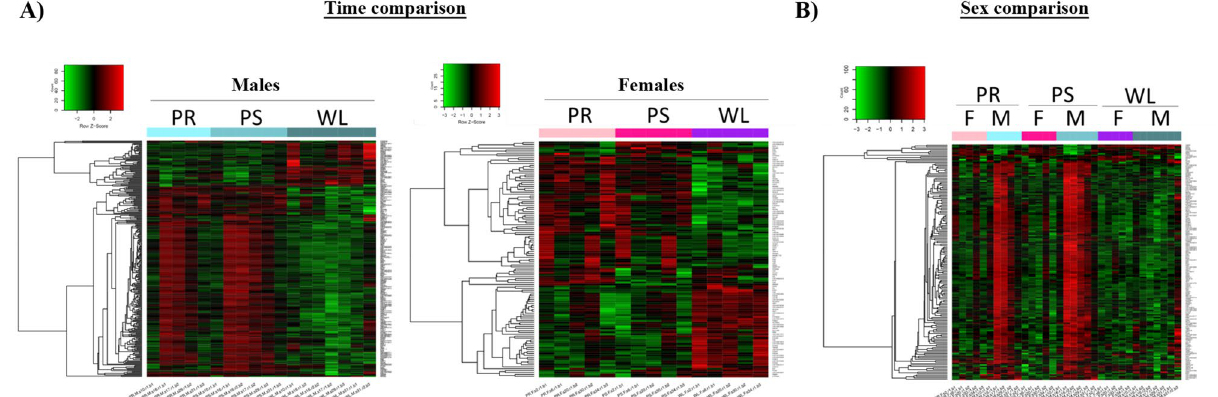
Figure 2. Hierarchical clustering of microarray assays based of kidney porcine throughout renal IRI in a time and sex manner. Gene expression for males and females were compared at different time points (PR, PS, and WL). ( A ) Heatmaps graphically illustrating the differences in the gene expression levels for the time comparison in males (left) and females (right). Similar pattern of expression was observed for both sexes. ( B ) Heatmap representing the difference in expression by comparing males and females at the same time point (sex comparison). The green color represents genes with lower expression and the red color represent the ones with higher expression. Genes represented in the heatmaps have an adj. p value ≤ 0.25 and |log FC| ≥ 1. F female, M male, PR pre-ischemia, PS post-ischemia, WL one week